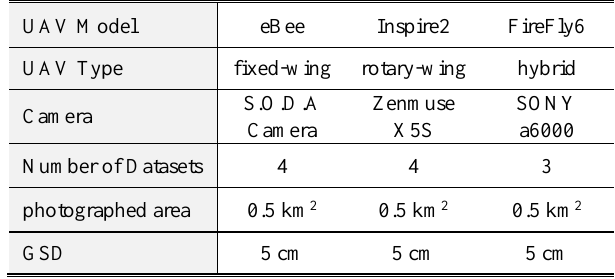
Table 1. Experiment